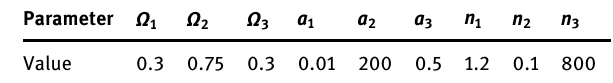
Figure 11: First mode shape of the SSAR.